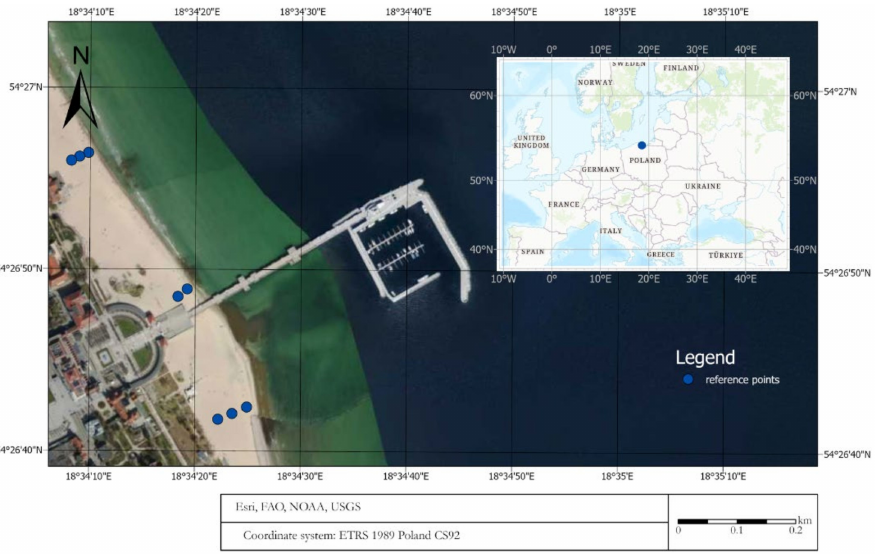
Figure 1. Map showing the measured waterbodies during the oceanographic phenomenon campaign conducted in Sopot in